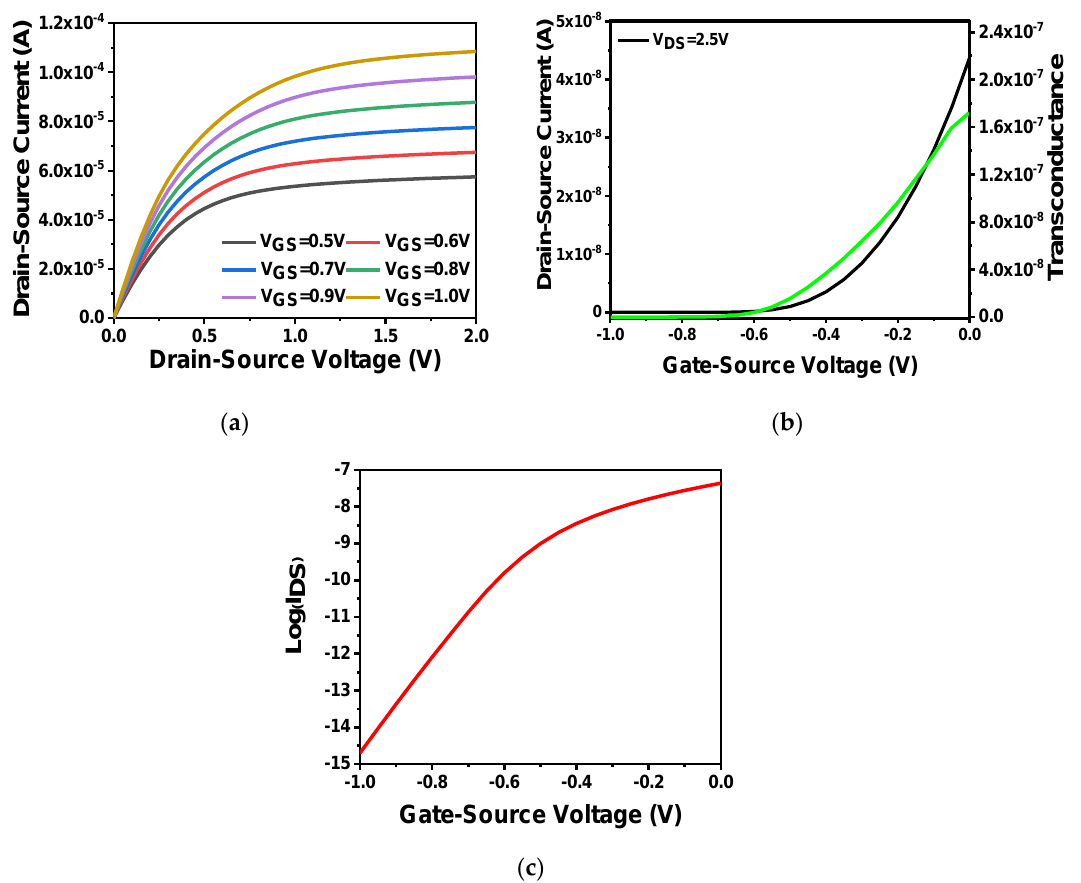
Figure 2. In 2 O 3 nanobelt FET characteristics: ( a ) device output characteristic curve; ( b ) the black curve is the transfer characteristic curve corresponding to the left coordinate, and the green curve is the transconductance curve corresponding to the right coordinate; ( c ) semilogarithmic curve of the relationship between source – drain current and gate – voltage ( 𝑉 𝐷𝑆 = 2.5 V )